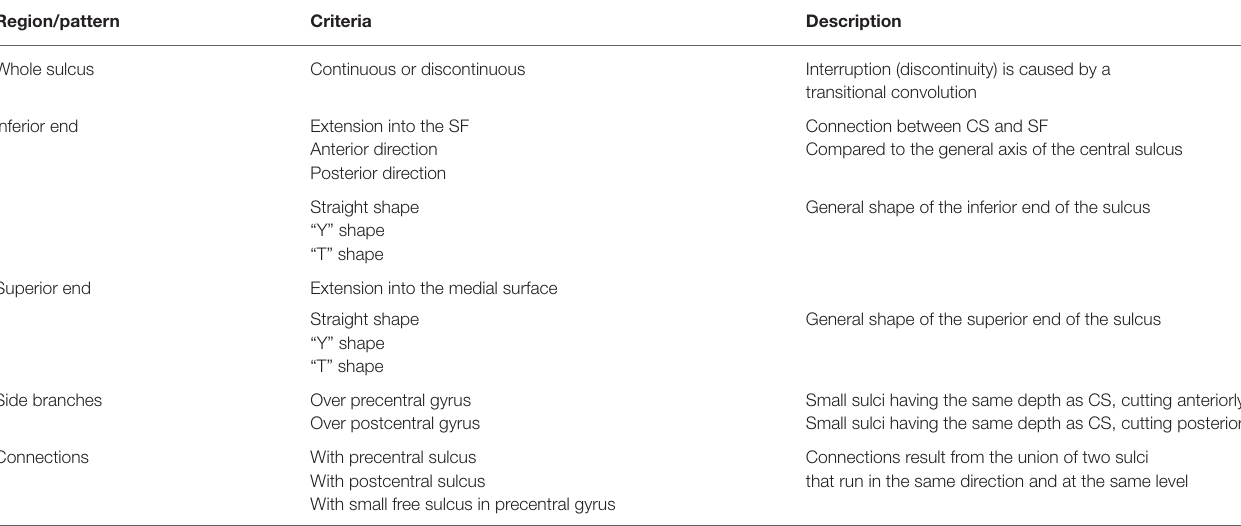
TABLE 1 | Description of the 16 criteria defining the pattern of the CS.